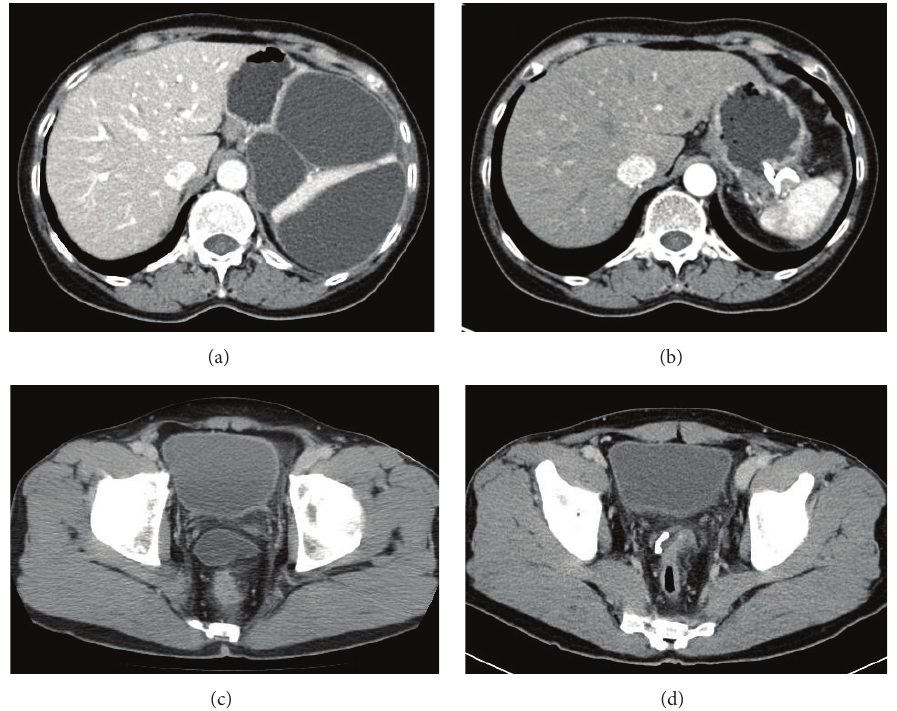
Figure 3: Computed tomography images (a–d). (a) A 13 cm pseudocyst in a patient with IgG4-related pancreatitis, and (b) resolution image of the pseudocyst after stent placement. (c) A 5.5 cm perirectal abscess in a patient with previous perforated diverticulitis, and (d) reduction in abscess size after stent